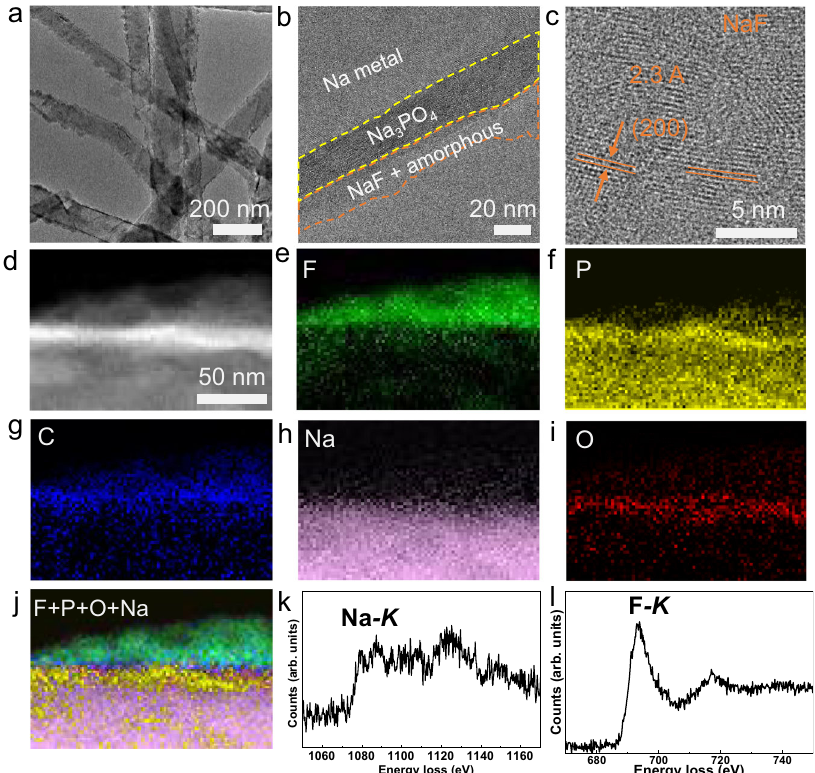
Fig. 4 Microstructure and composition analysis of the SEI in EC:DMC-FEC electrolyte after the 10th cycle. a Low magni fi cation cryo-TEM image of the Na dendrite. b Higher-magni fi cation view of the SEI. c HRTEM of surface region containing nanocrystalline NaF. d STEM image of SEI layer. EELS elemental maps of e F, f P, g C, h Na, i O, and j composite map; k , l Na and F K -edge EELS